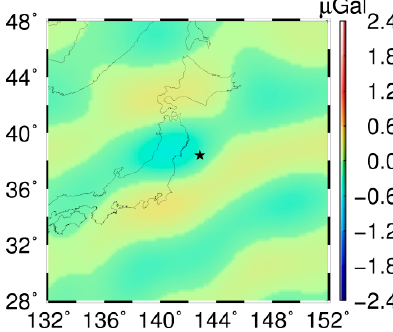
Figure 9. Gravity changes on a sphere with a height of 260 km computed by the tailored spherical harmonic coefficients from GRACE (the Gravity field Recovery and Climate Experiment). The SH degree range is 30–95. The unit is μ Gal.